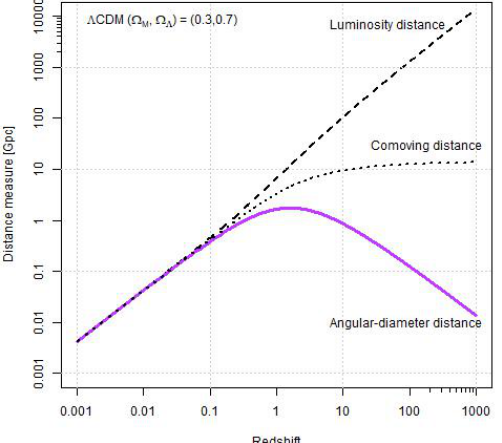
Figure 1. Angular-diameter distance D A (purple curve) as calculated within the Λ CDM model for H 0 = 70kms − 1 Mpc − 1 . The luminosity distance D L (dashed line) and comoving distance D C (dotted curve) are also shown for